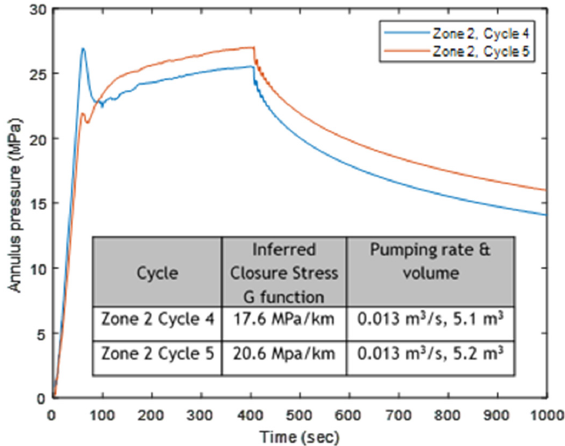
Figure 18. Comparison of two sequential cycles, Cycle 4 and Cycle 5, for Zone 2.